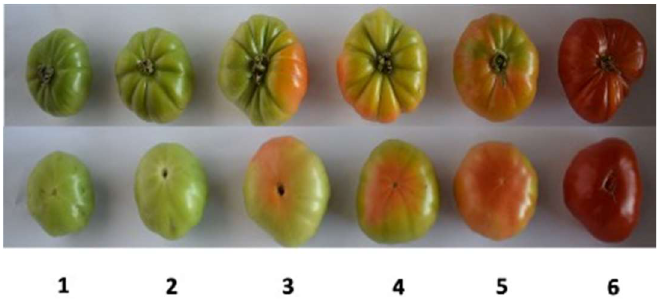
Figure A1. Colour classification requirements in Old Limachino Tomato based on USDA (1976): (1) Green, (2) Breakers, (3) Turning, (4) Pink, (5) Light Red and (6) Red.